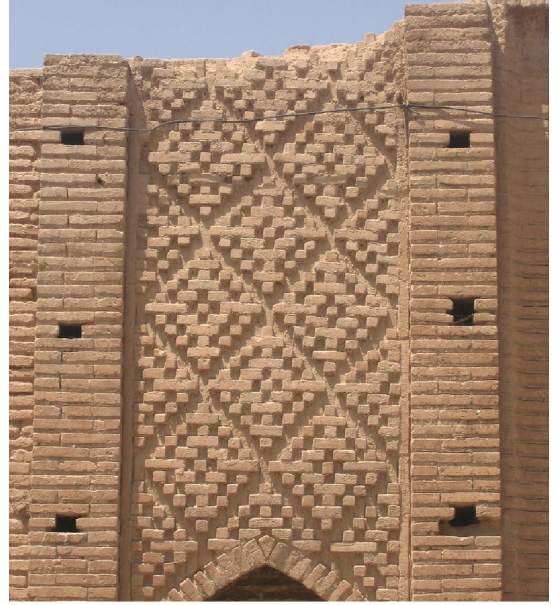
Fig. 13 Gol-E-Bozorg Xowun in Mirza Ebrahimi house. Source: MCHT of